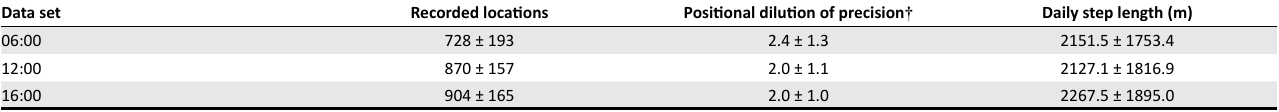
TABLE 1-A2: Descriptive statistics of daily elephant location data recorded in the morning (06:00), midday (12:00) and afternoon (16:00). For each parameter, the mean ± s.d. is reported for seven female elephants in Addo Elephant National Park, South Africa. Data